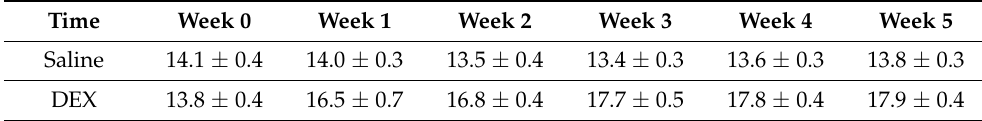
Table 1. Comparison of Weekly IOP (mm Hg)